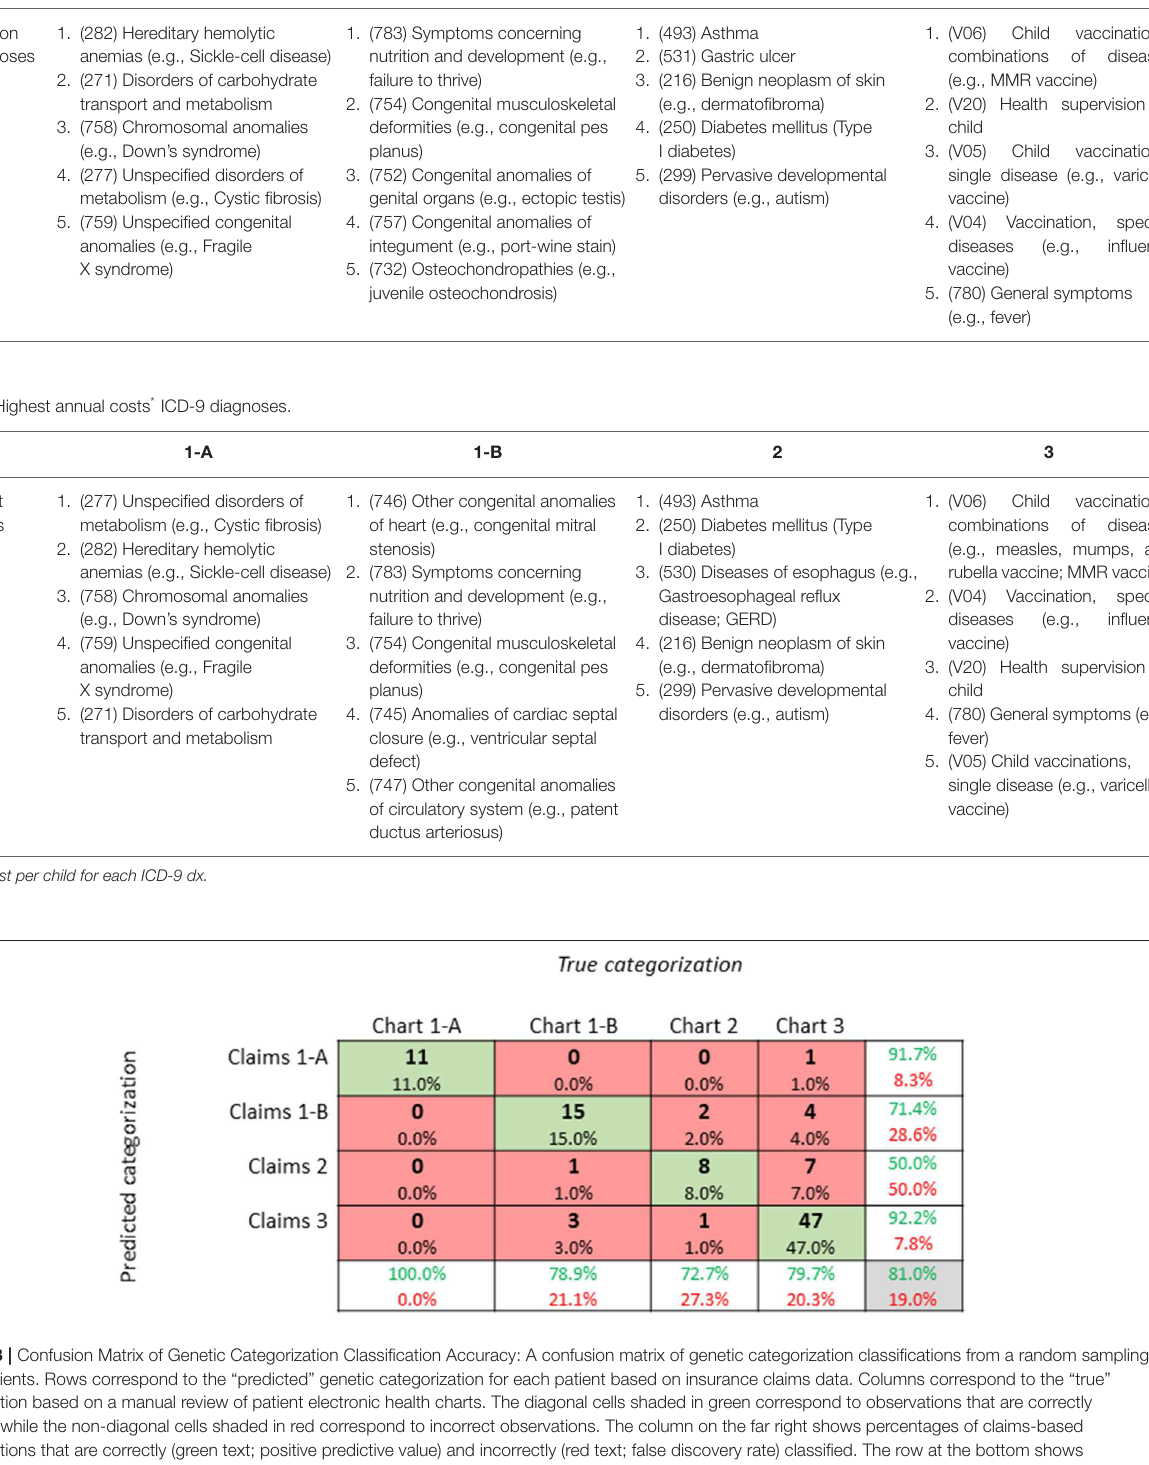
TABLE 4 | Clinical profile (ICD-9 Diagnoses) of children per category. Category